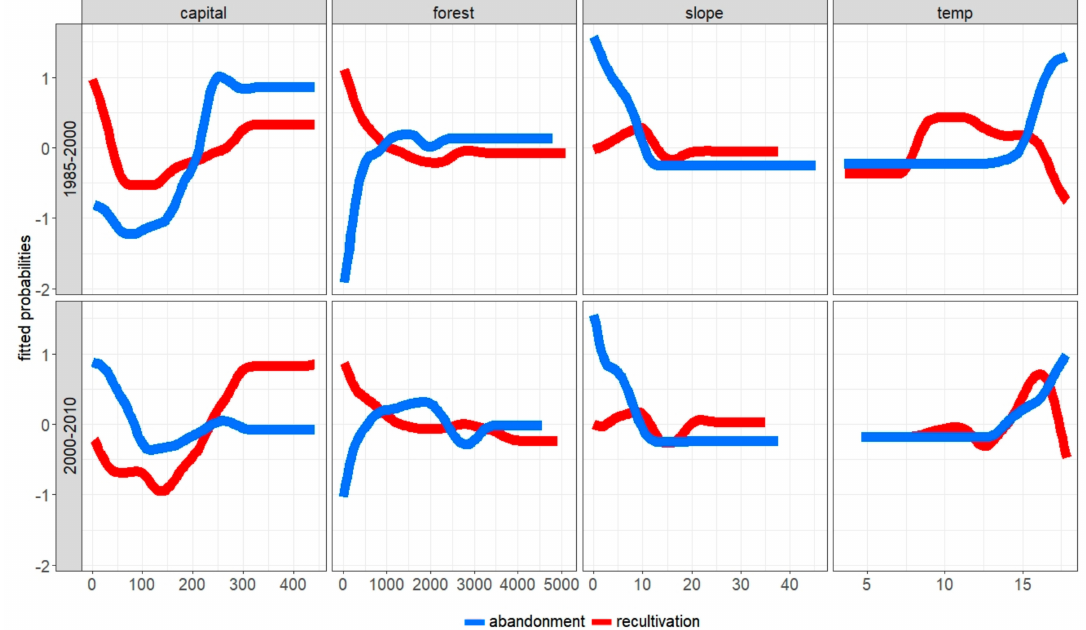
Figure 6. Fitted probabilities of abandonment of agricultural land (red line), and its recultivation (blue line) and their response to response to increases in distance to the capital city, distance to forests, slope and temperature. The x-axis values correspond to the measured ranges of particular